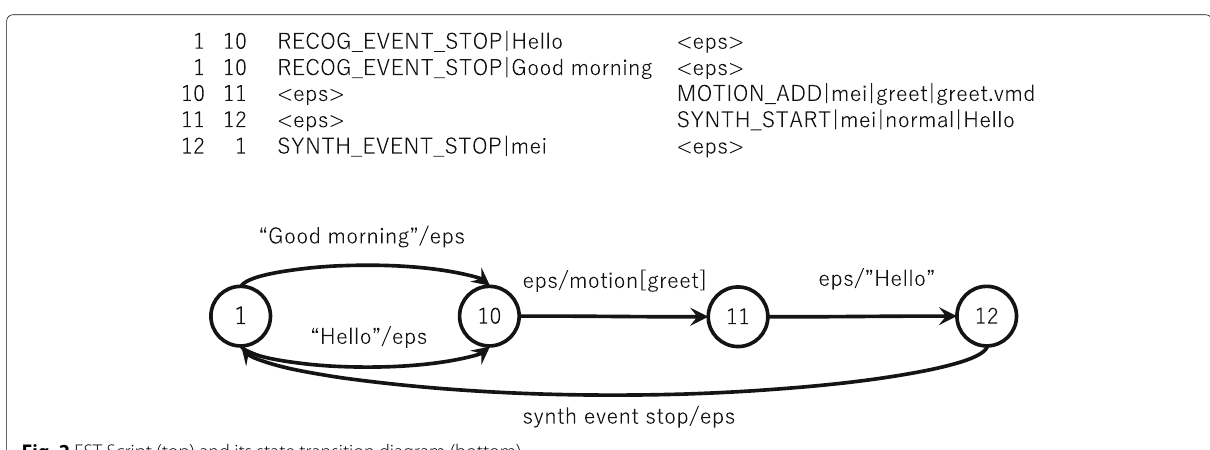
Fig. 2 FST Script (top) and its state transition diagram